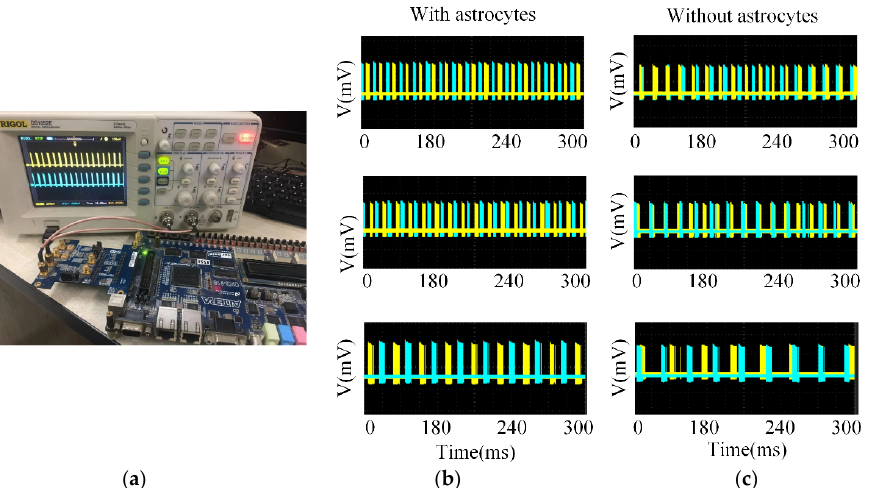
Figure 12. Hardware implementation results of self ‐ repairing CPG network. ( a ) Hardware used in the experiment; ( b ) The discharge time series of BiSRP ‐ CPG; ( c ) The discharge time series of the CPG model without astrocytes. The discharge loss rates from top to bottom are 20%, 30%, and 40%.